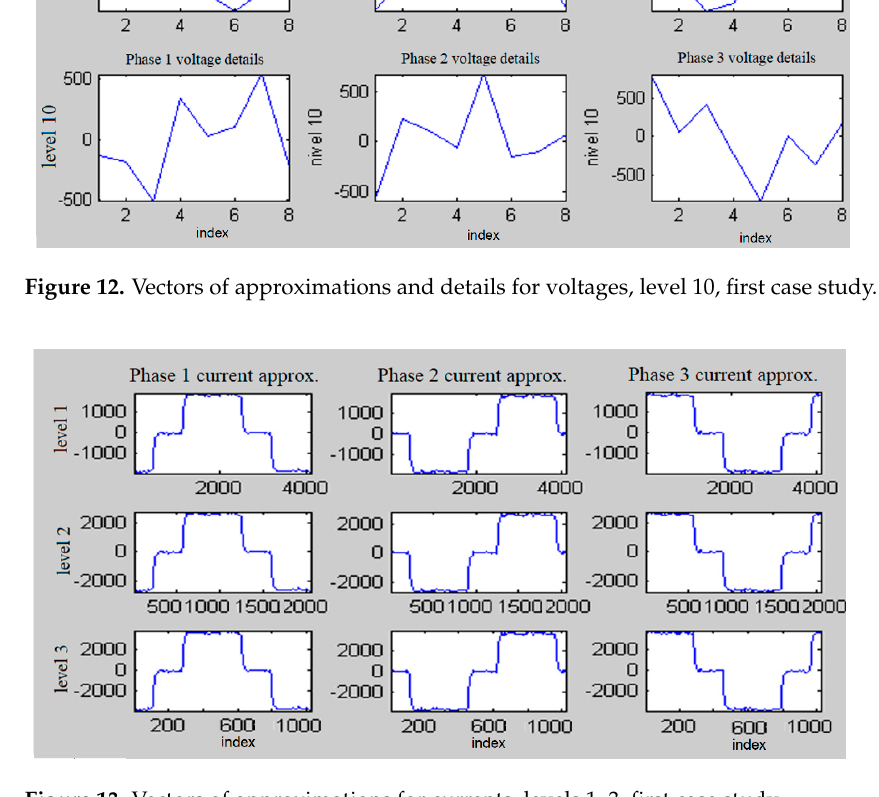
Figure 13. Vectors of approximations for currents, levels 1–3, first case study.